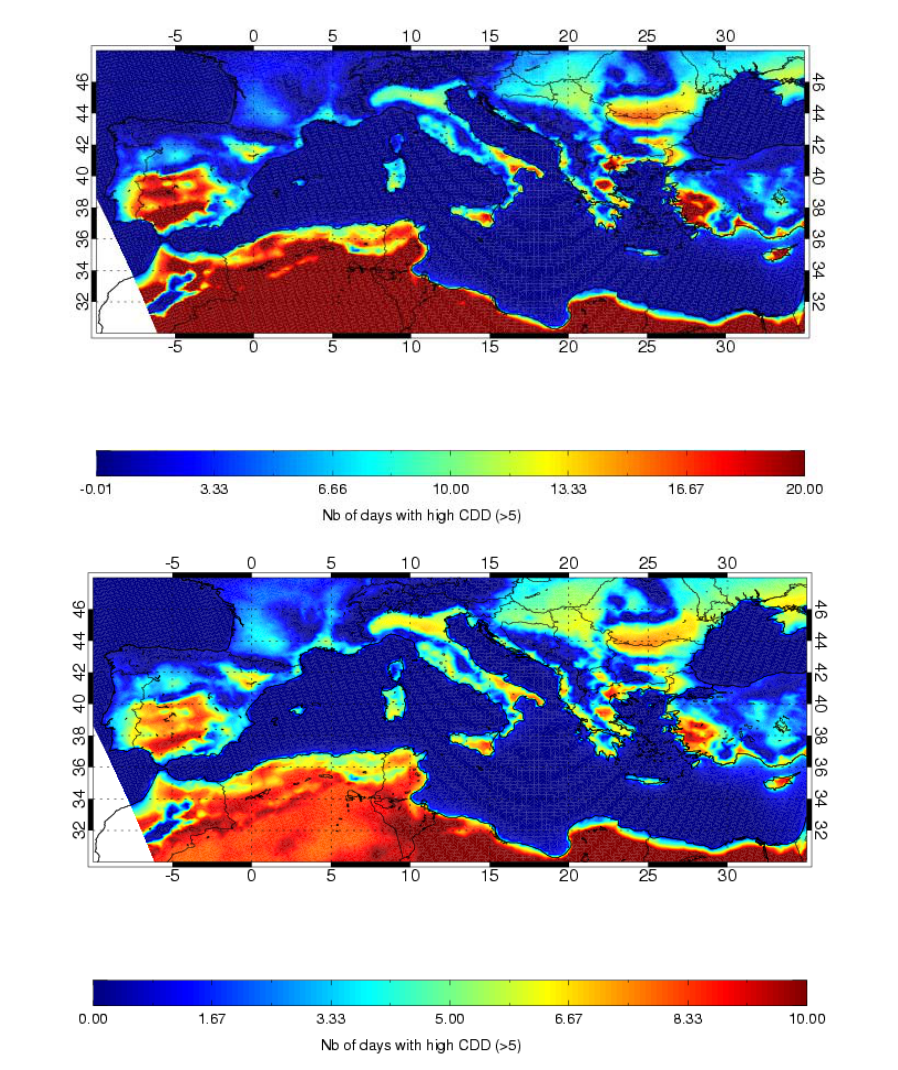
Figure 3. Changes in the number of days with high CDD (CDD > 5) between future and control period (top) and standard deviation of the changes